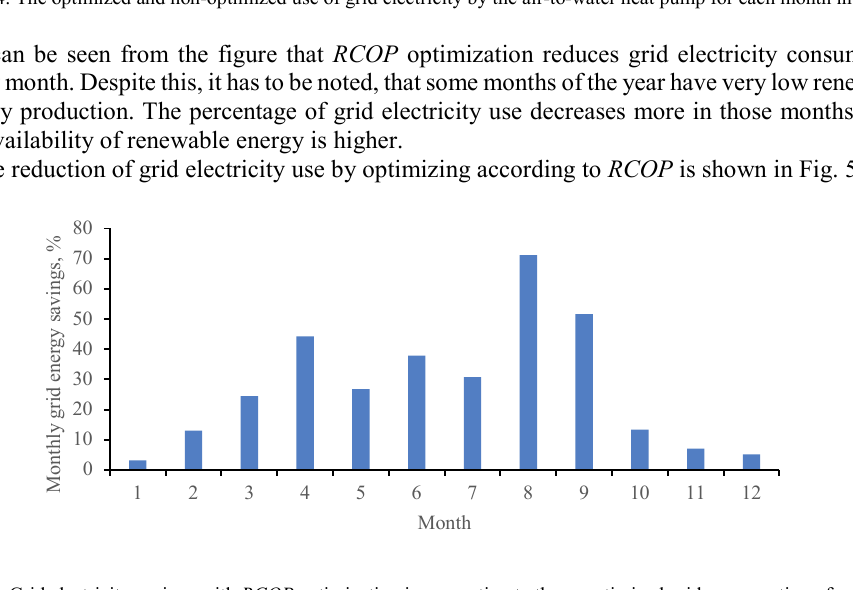
Fig. 4. The optimized and non-optimized use of grid electricity by the air-to-water heat pump for each month in